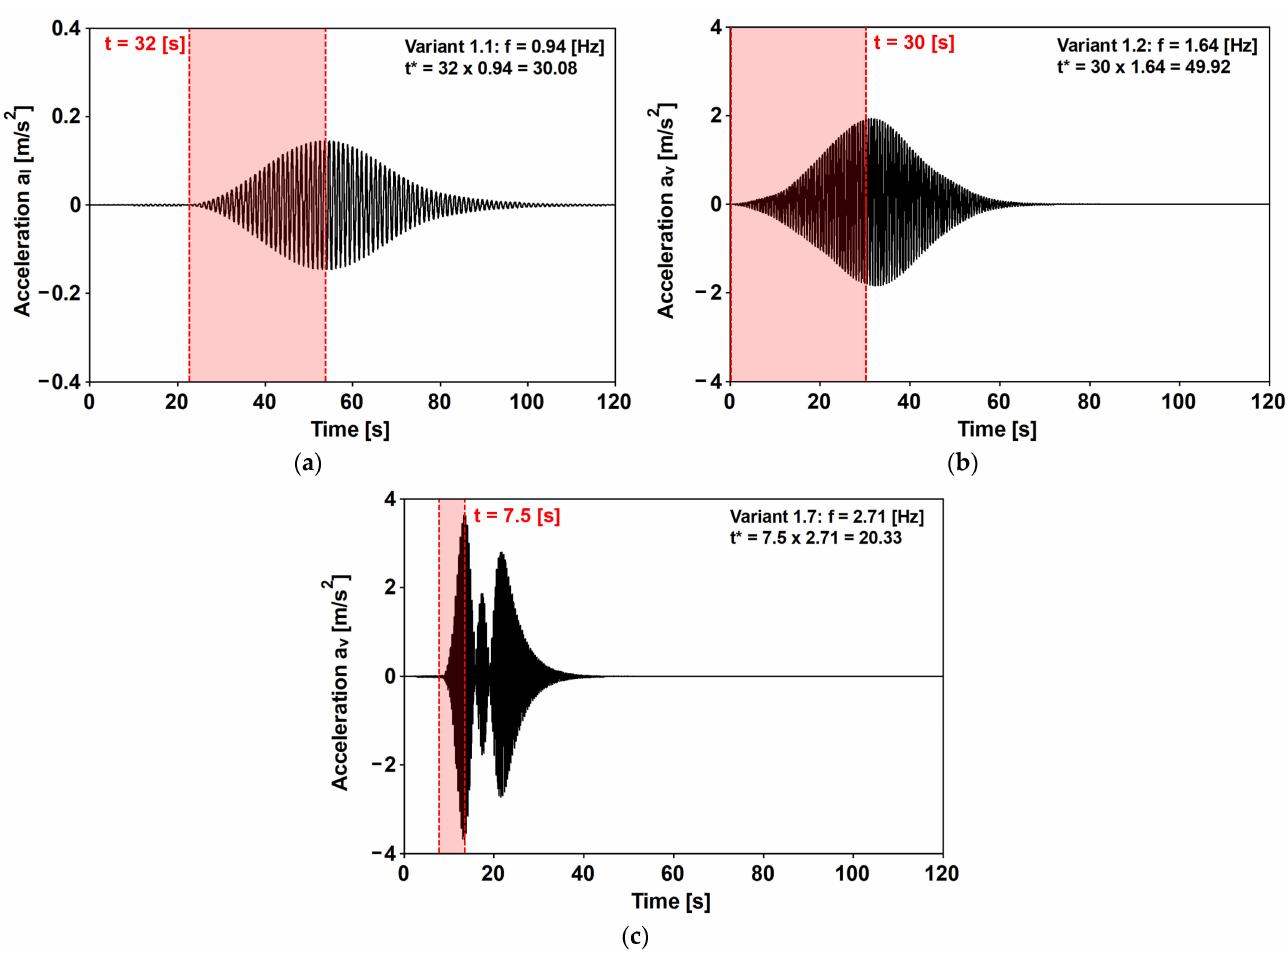
Figure 15. The evaluation of the normalized time for ( a ) Variant 1.1—the lateral vibrations that are induced by walking (f 1 = 1.88 Hz); ( b ) Variant 1.2—the vertical vibrations that are induced by walking (f 2 = 1.64 Hz); and ( c ) Variant 1.7—the vertical vibrations that are induced by running (f 5 = 2.71 Hz). The time histories at the P3 station are obtained by assuming the 2019 experimental critical damping values